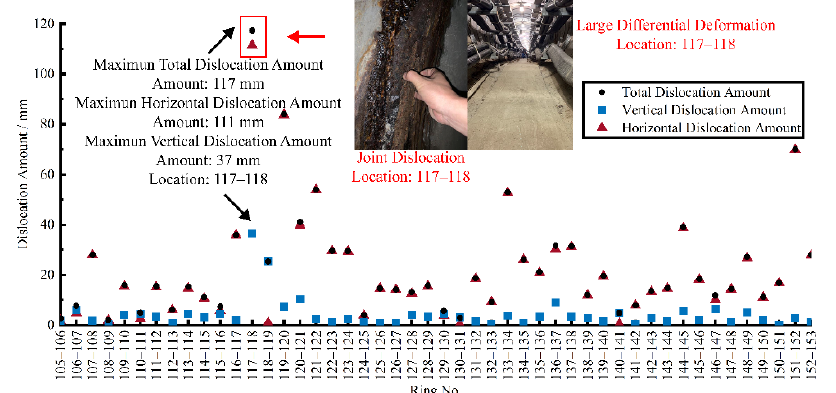
Figure 12. Correlation between the shearing deformation and tunnel defect.